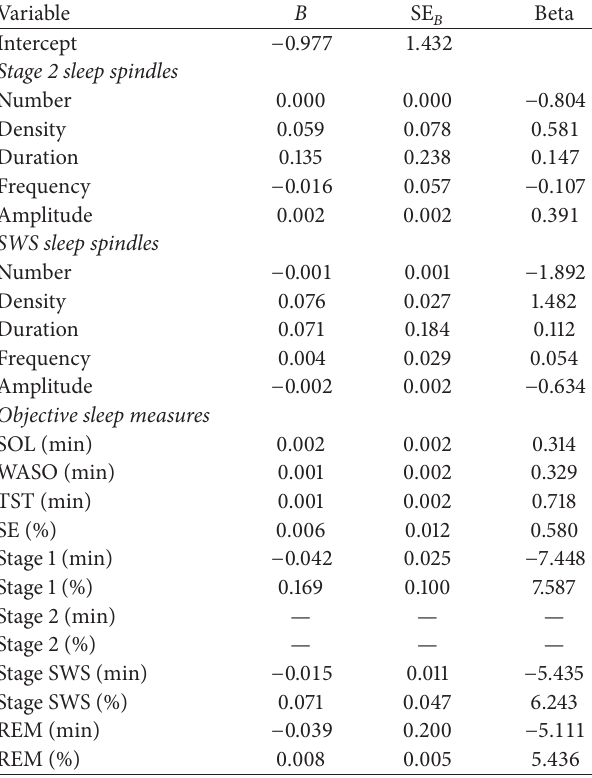
Table 6: Summary of multiple regression analysis for underestima- tion (Misperception Index >